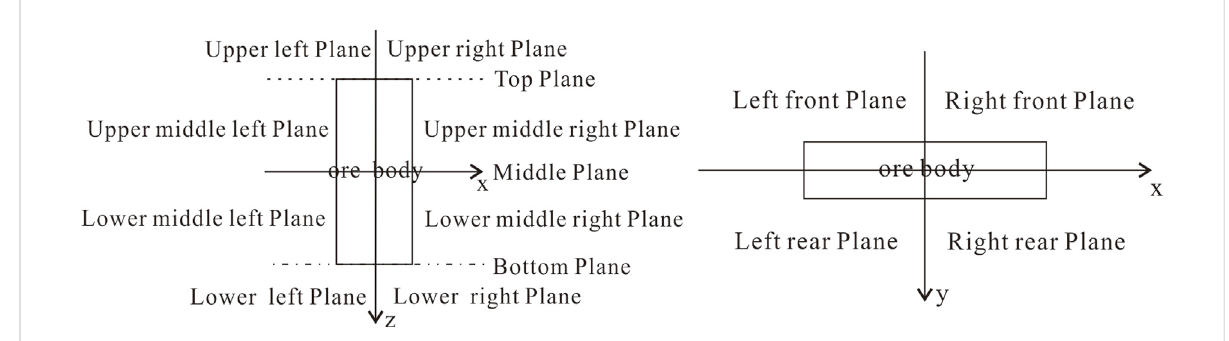
FIGURE 3 Schematic of the division of the xoz and xoy sections of vertical cuboid